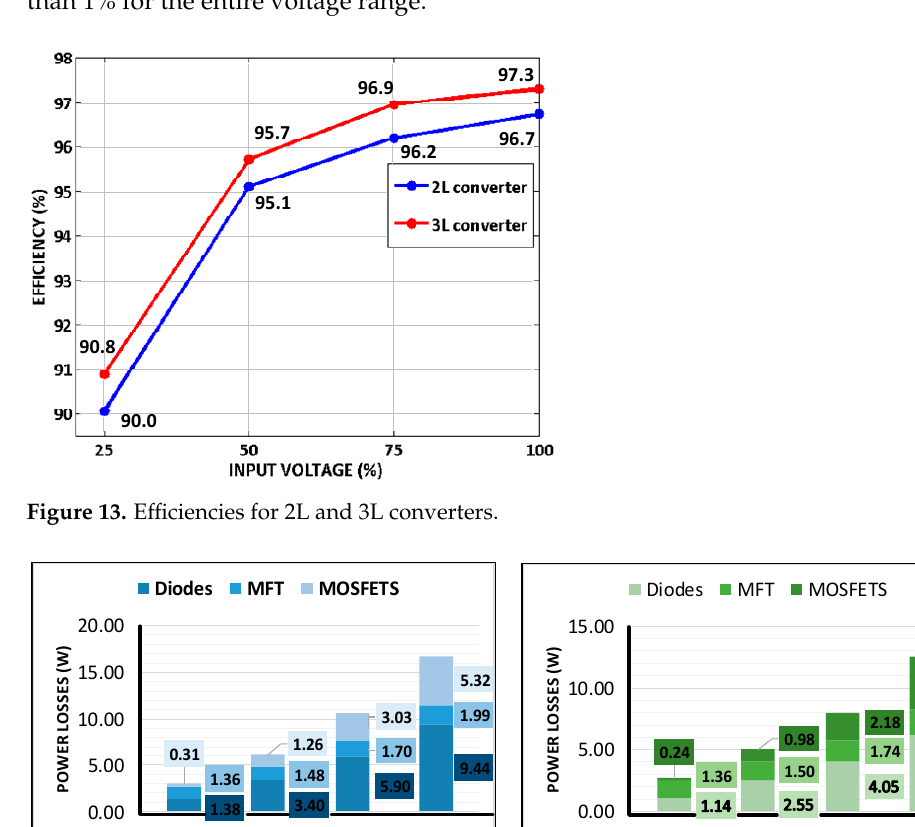
Figure 13. Efficiencies for 2L and 3L converters.